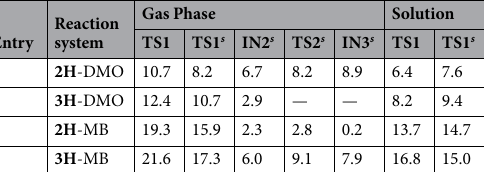
Table 2. Predicted relative Gibbs free energies for hydrogen transfers involved in the hydrogenation of esters. Unit in kcal/mol. “ s ”refers to 2H s and 3H s , which is the simplified model of 2H and 3H .